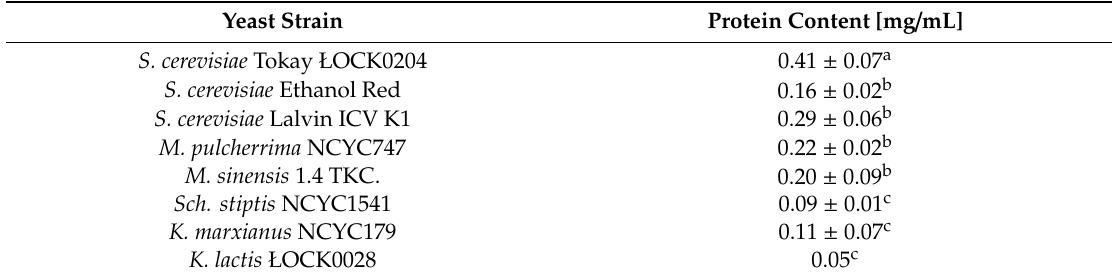
Table 1. Protein content in hydrolysate fermented using di ff erent yeast